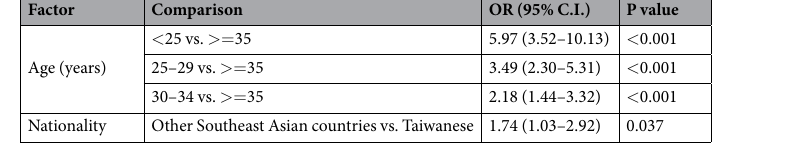
Table 3. Multiple logistic regression analysis for factors associated with HBeAg among HBsAg-positive